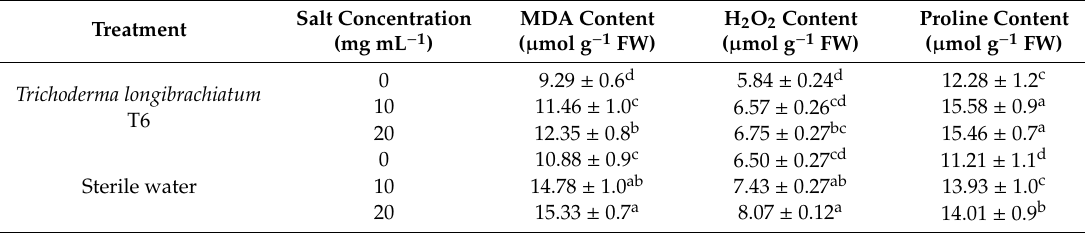
Table 3. E ff ect of Trichoderma longibrachiatum T6 on MDA, H 2 O 2 and proline contents in wheat seedlings under salt